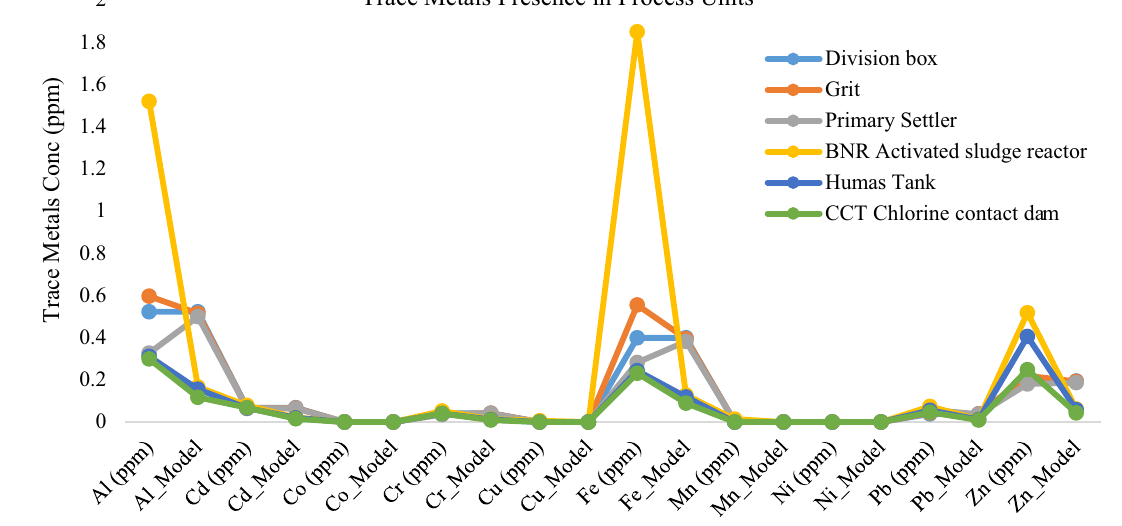
Fig. 2 Speciation of the trace metals in the activated sludge